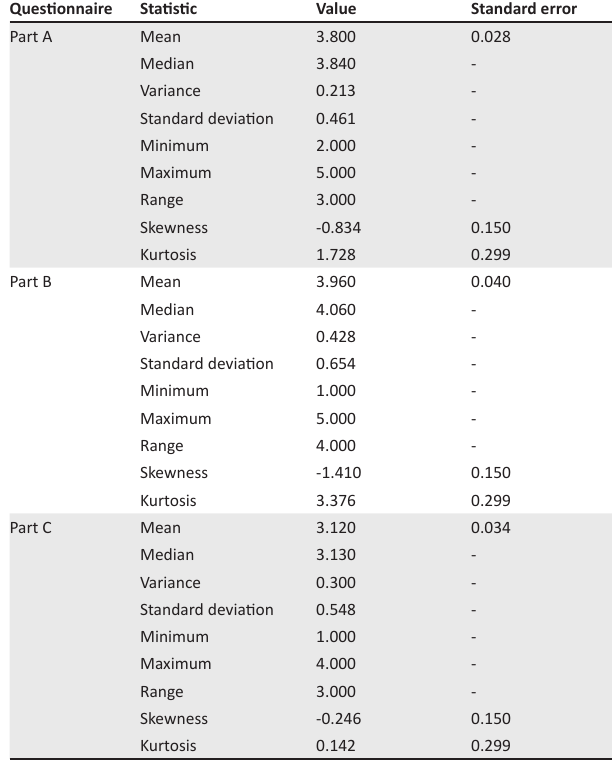
TABLE 4: Descriptive statistics